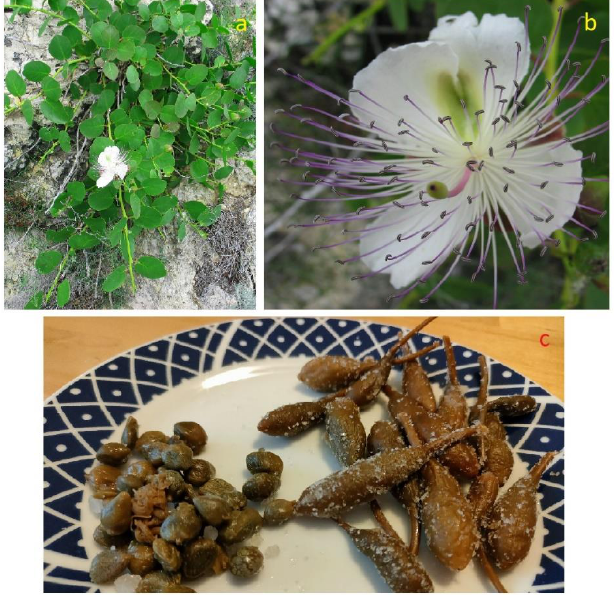
Figure 15. Capparis spinosa ( a ) and a detail of the flower ( b ); caper buds and fruits in salt ( c